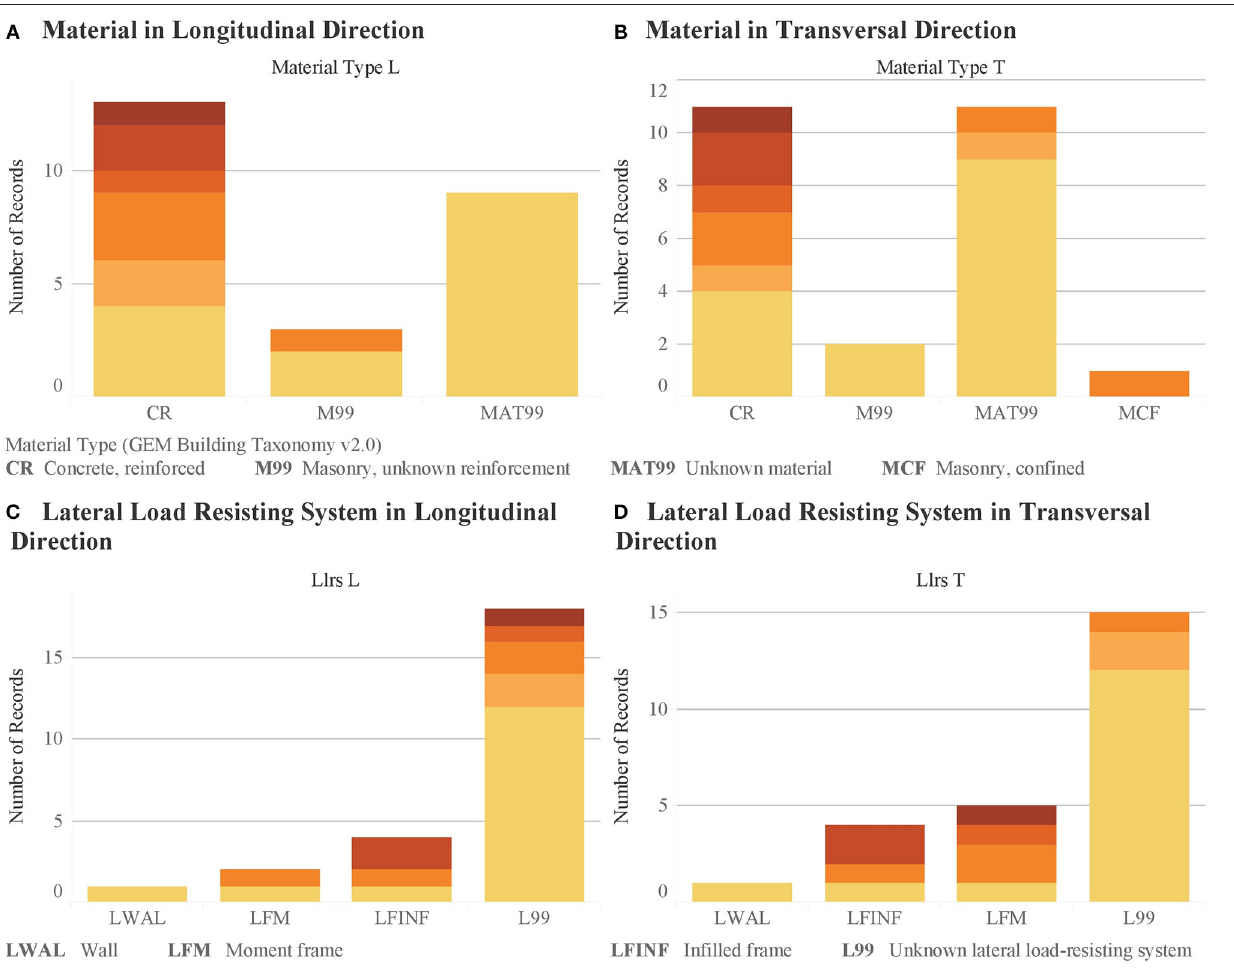
FIGURE 8 | Dashboard showing the material and type of lateral load resisting system. Material of structural system in longitudinal direction (A) and transversal direction (B) . Lateral Load Resisting system in longitudinal direction (C) and transversal direction (D) .